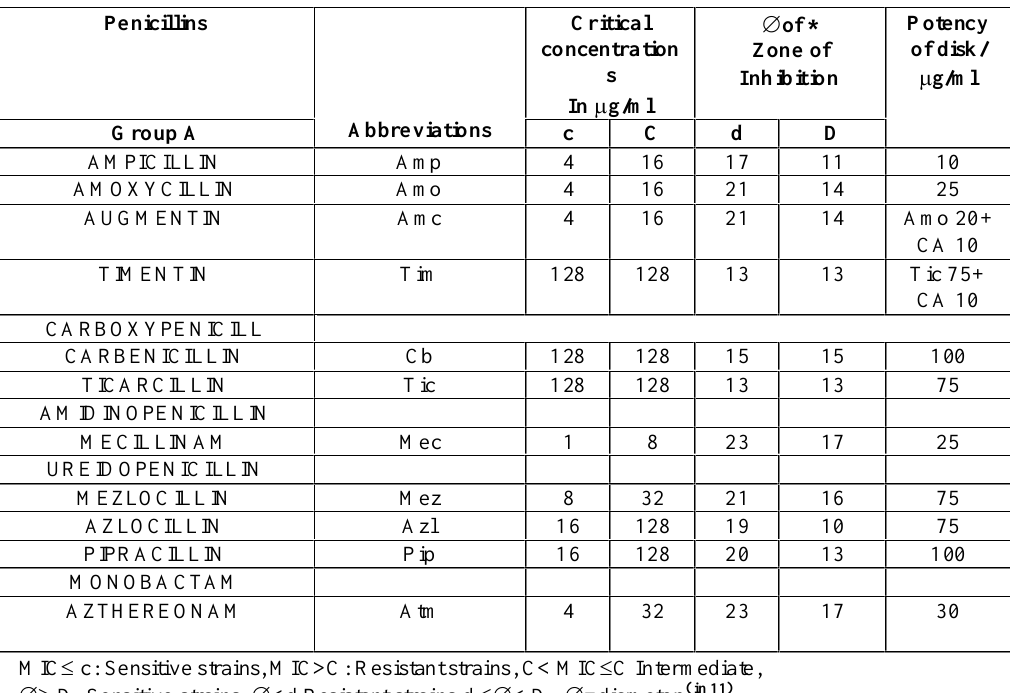
Table (2) Standard values of MICs and diameters (  ) of zone of inhibition of Penicillins. Penicillins